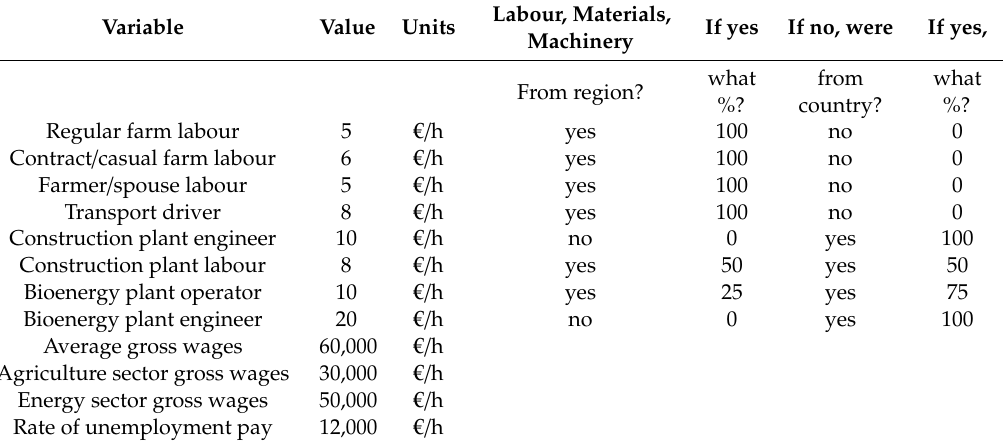
Table A4. Labour costs.